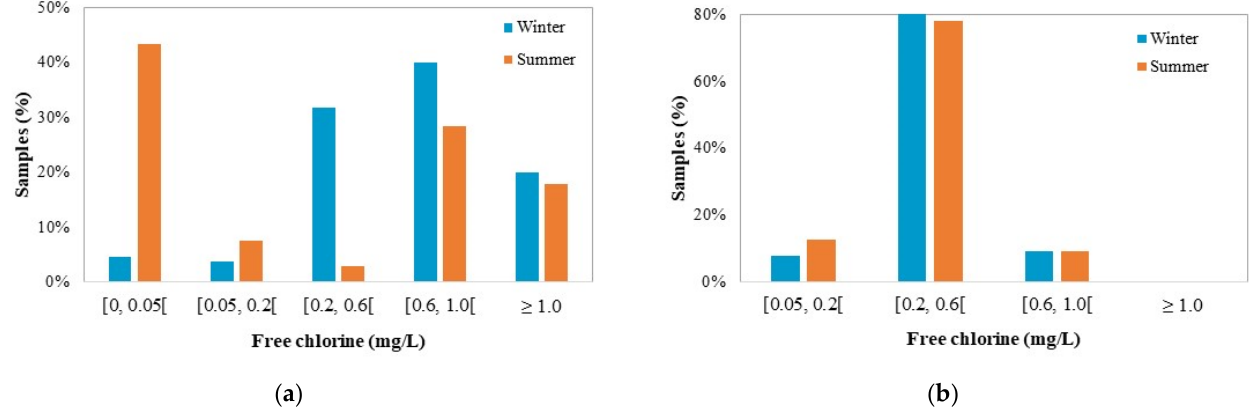
Figure 5. Chlorine concentrations at sampling nodes for ( a ) Case Study 1 and ( b ) Case Study 2.